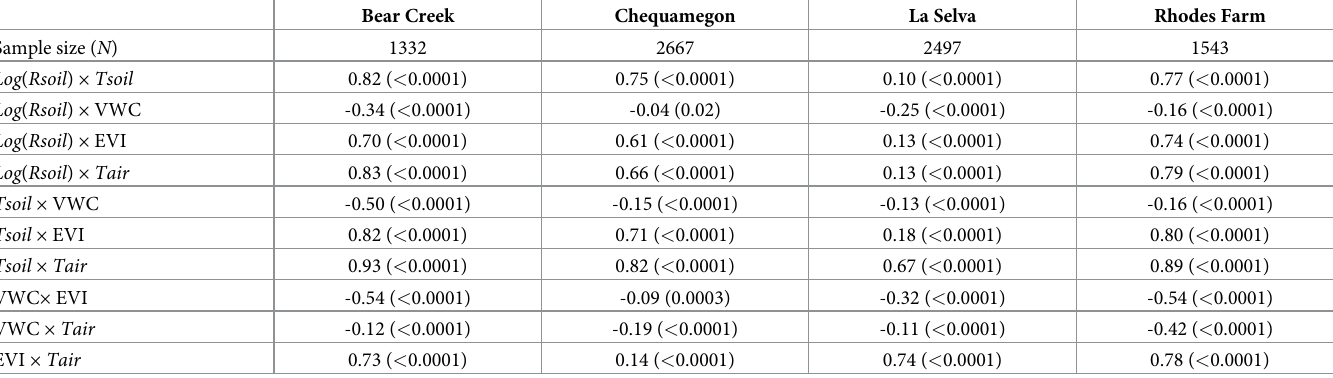
Table 2. Pearson product-moment correlations ( r ) between individual measurements of Rsoil and paired measurements of environmental variables at each of the four study sites. Bear Creek Chequamegon La